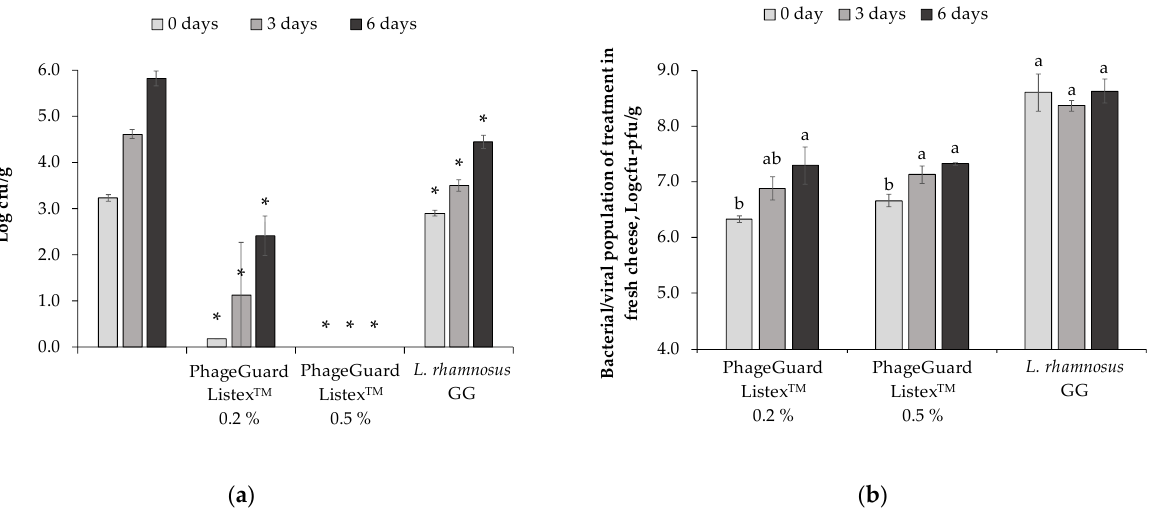
Figure 4. Effect of the biopreservative treatments in fresh cheese under semi-commercial evaluation (4 ◦ C): ( a ) L. innocua population in fresh cheese. Values are means ± standard deviations of three biological replicates. Bars marked with an asterisk represent statistically significant differences between the treatment and the control ( p < 0.05) at each sampling time. ( b ) Counts of bacteriophage P100 (formulated in PhageGuard Listex TM treatment) and L. rhamnosus GG in fresh cheese at 0, 3, and 6 days of storage at 4 ◦ C. Values are means ± standard deviations of three biological replicates. Bars marked with different letters (a and b) represent statistically significant differences among sampling time ( p < 0.05) at each evaluated